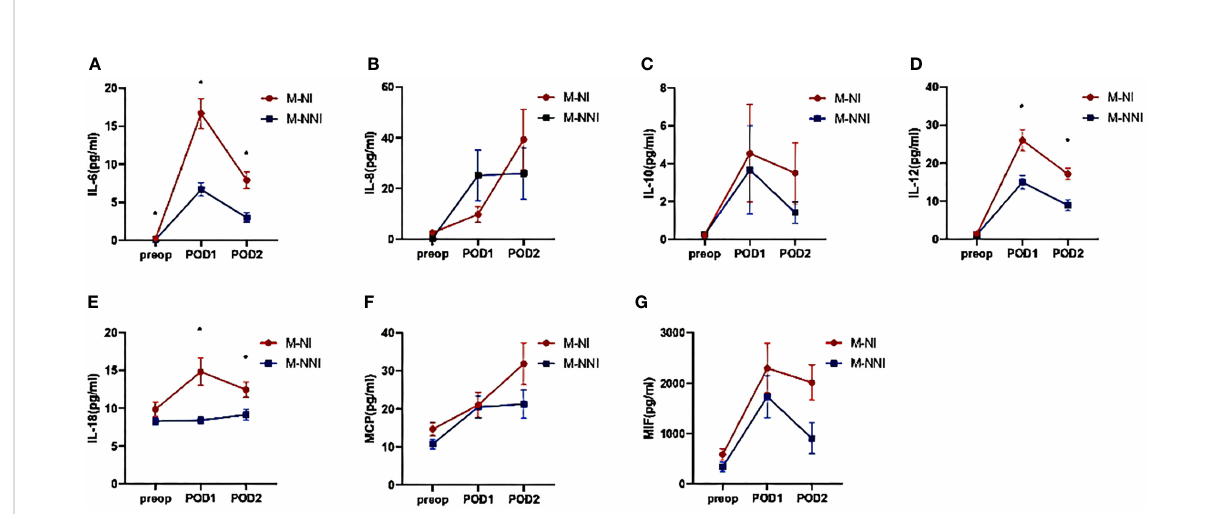
FIGURE 2 Serum in fl ammatory factor levels on pre-operation, 0-hour post-operation, and 24-hour post-operation. (A) The levels of IL-6 increased after the surgery and were signi fi cantly different between the M-NI and the M-NNI groups at three-time points. The time taken to reach the peak level was at POD1. (B, C) The increasing levels of IL-8 and IL-10 did not show signi fi cant differences between the M-NI and the M-NNI groups. (D) The levels of IL-12 were signi fi cantly different between M-NI and M-NNI groups at POD1 and POD2. The time to peak was at POD1. (E) The postoperative levels of IL-18 were signi fi cantly higher in the M-NI group and the time to peak in the M-NI group was POD1. (F, G) MCP and MIF showed higher levels in the M-NI group than in the M-NNI group at POD2. IL, interleukin; MCP, monocyte chemoattractant protein; MIF,